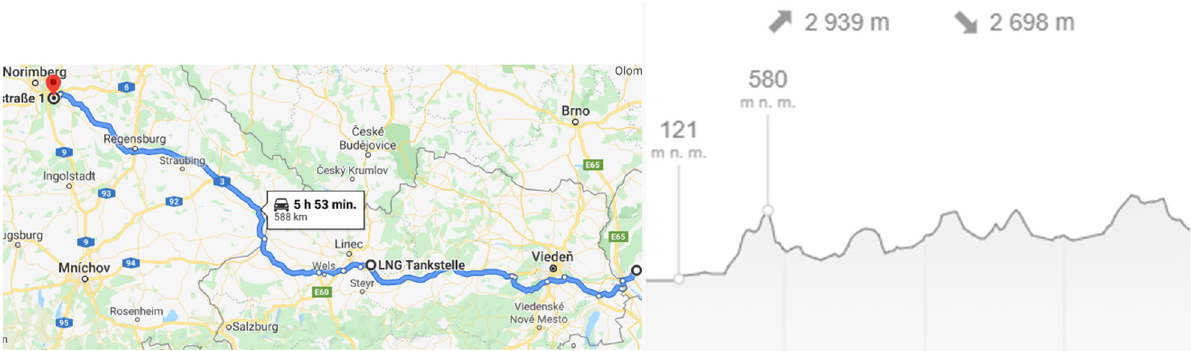
Figure 1: Transport route and route altitude pro fi le Ivanka pri Dunaji – Schwarzenbruck [ 46 ] .